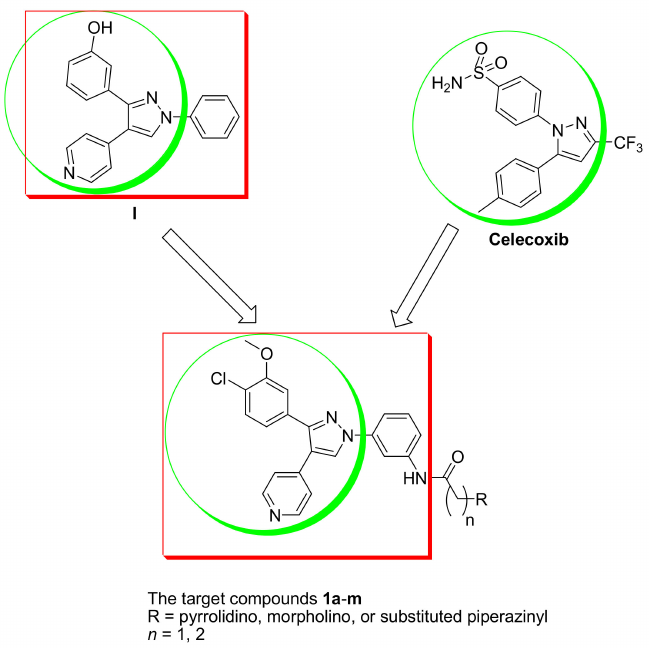
Figure 1. Structures of the lead compound I [18], celecoxib, and the target compounds 1a – m